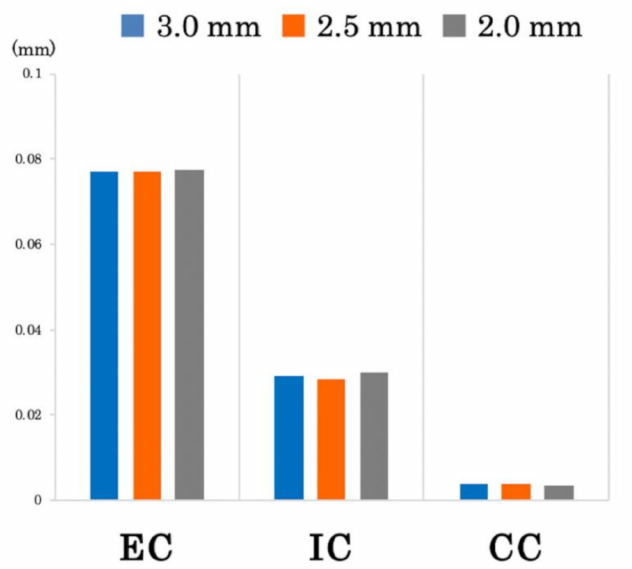
Figure 9. Size of the microgap between the abutment and the implant body in each model. EC: external connection; IC: internal connection; CC: conical